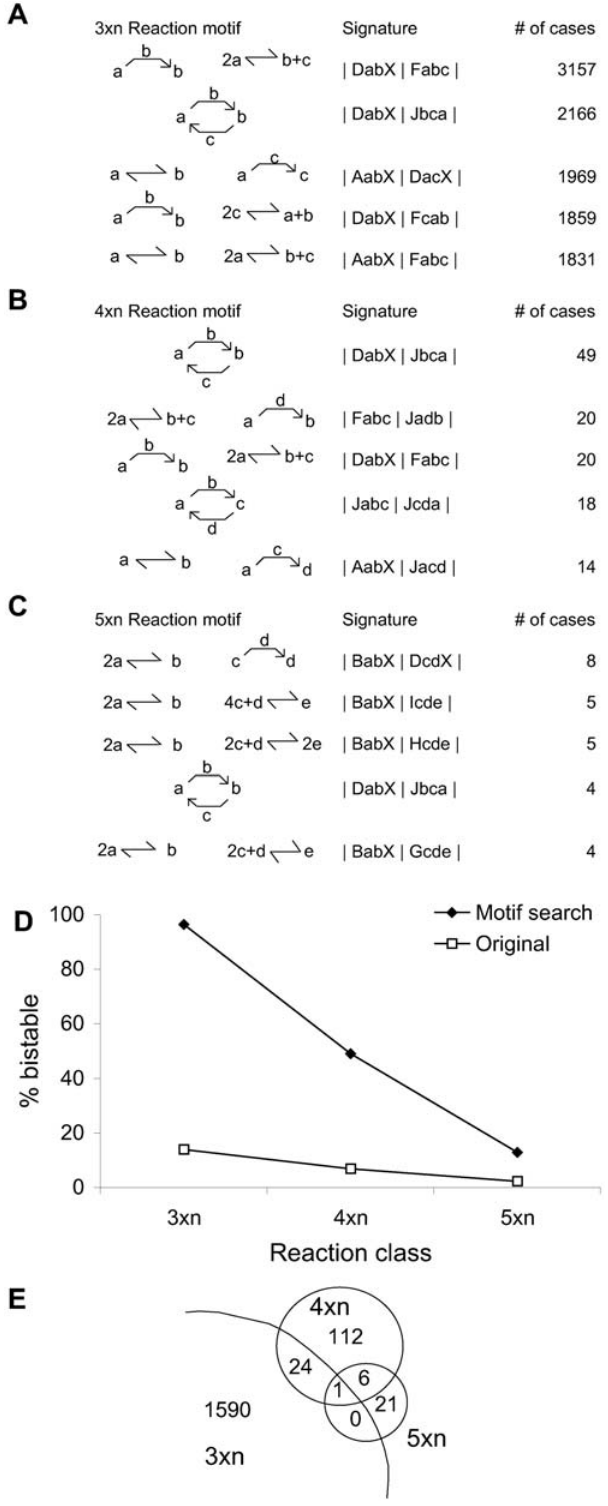
Figure 6. Motifs in Bistable Switches. (A–C) Top 5 motifs mined for 3-molecule, 4-molecule, and 5-molecule bistable systems. (D) Motifs improve search for bistables by about 7-fold, for each of the reaction classes tested. (E) Venn diagram of motifs among different classes of reaction configurations. The one motif shared by all classes of configurations is the same as the smallest bistable, model M101.